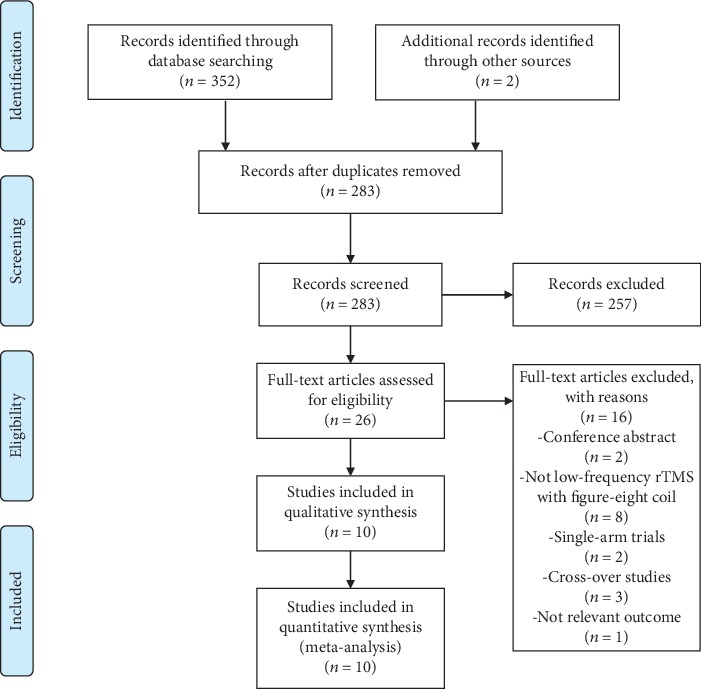
Flowchart for study selection process. rTMS = repetitive transcranial magnetic stimulation.